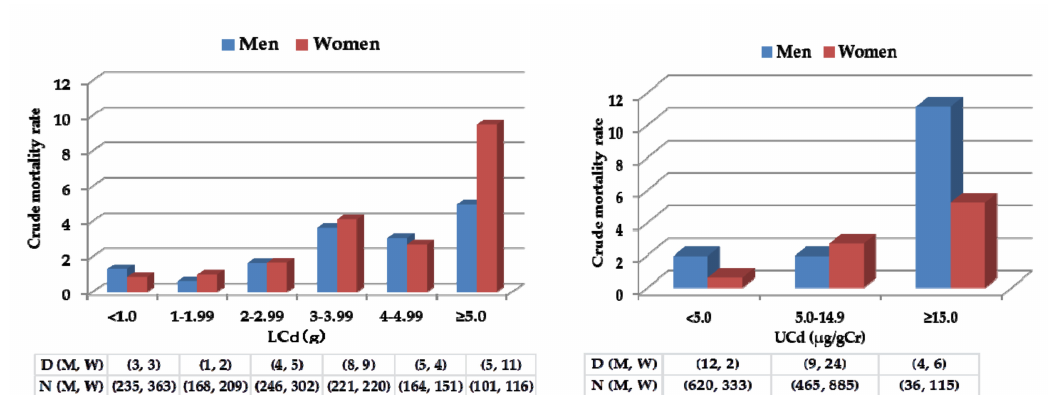
Figure 1. Crude mortality rates (%) for renal diseases and Cd exposure levels indicated by ( a ) LCd ( + 1 g) and ( b ) UCd (urinary Cd; + 10 µ g / g Cr). D (M, W): number of deaths for men and women; n (M, W): number of subjects of men and women.